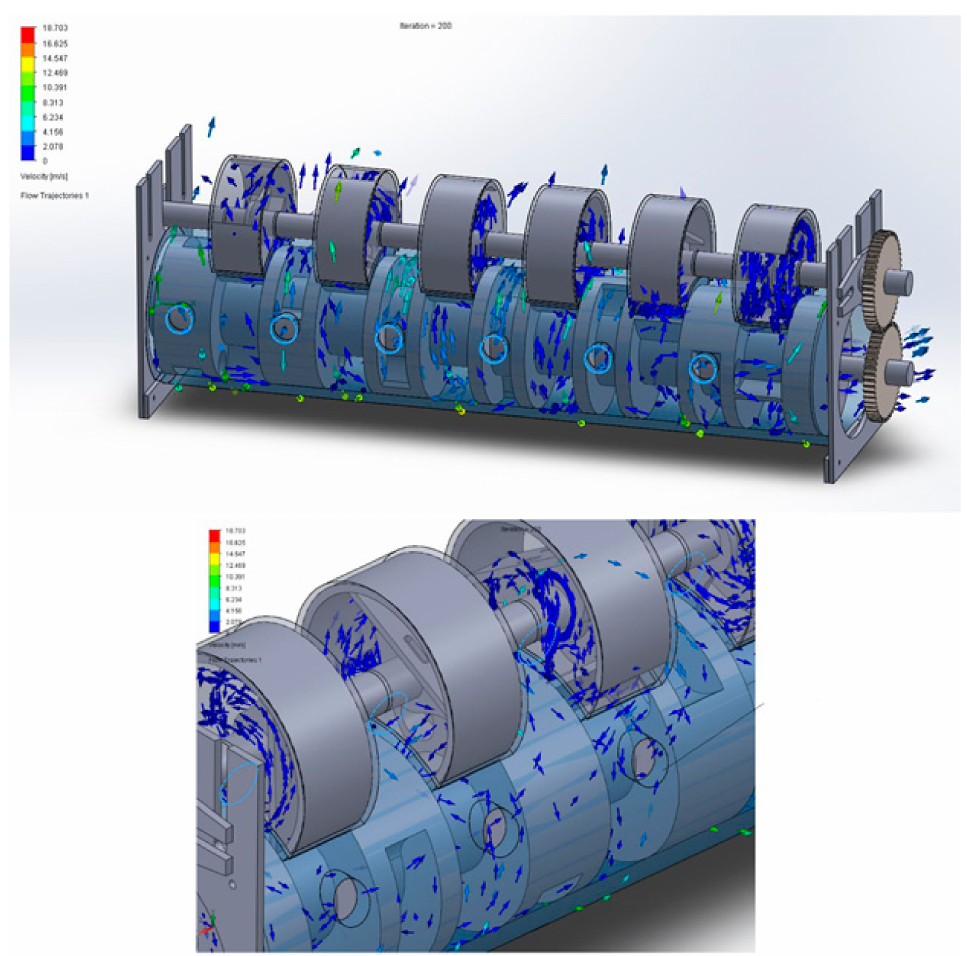
Figure 20. Visualization of water flow in the volume-sectional hydraulic